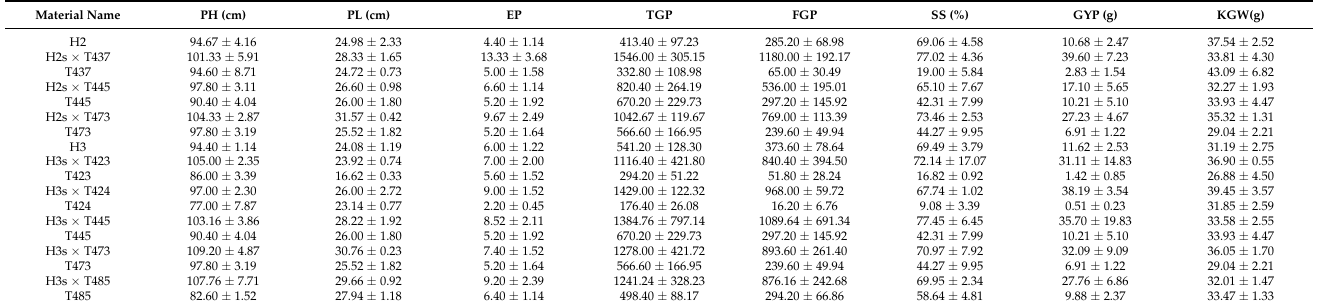
Table 1. Grain yield and yield components of wild type, parents and F 1 hybrid.